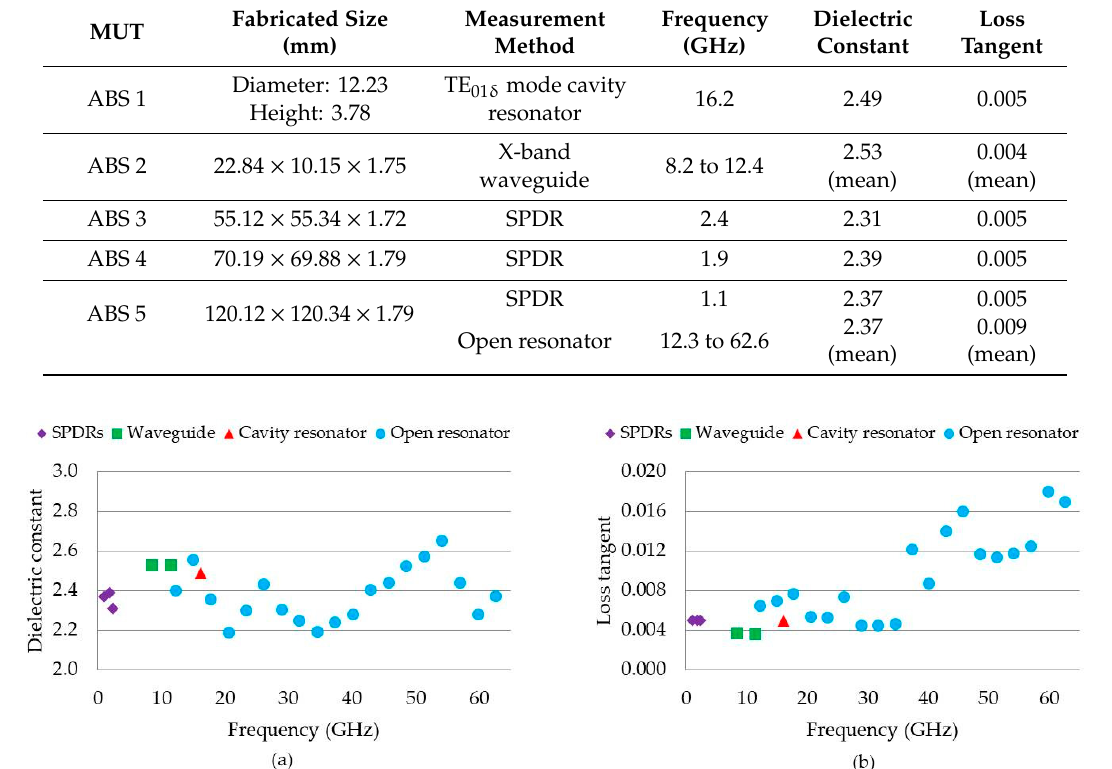
Table 5. Measured fabricated sizes, methods, and frequencies, together with the dielectric constant and loss tangent results of the ABS MUTs.